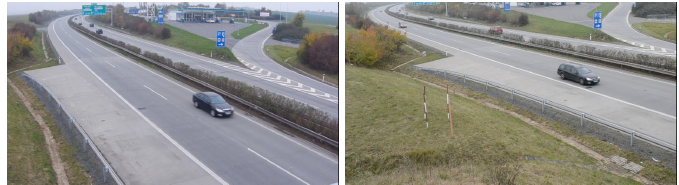
Figure 8. Sample images from the Automatic Traffic Surveillance Workshop on CVPR2016 [66]. All vehicles are recorded from two slightly different viewpoints. The dataset also contains annotation information that can be used to extract observations.